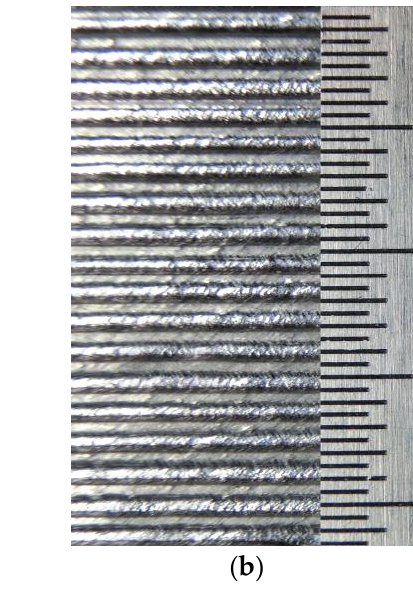
Figure 4. The deposited specimens in different layer thickness. ( a ) δ = 0.9 mm. ( b ) δ = 1.2 mm. ( c ) δ = 1.5 mm. ( d ) δ = 1.8 mm. ( e ) δ = 2.1 mm.